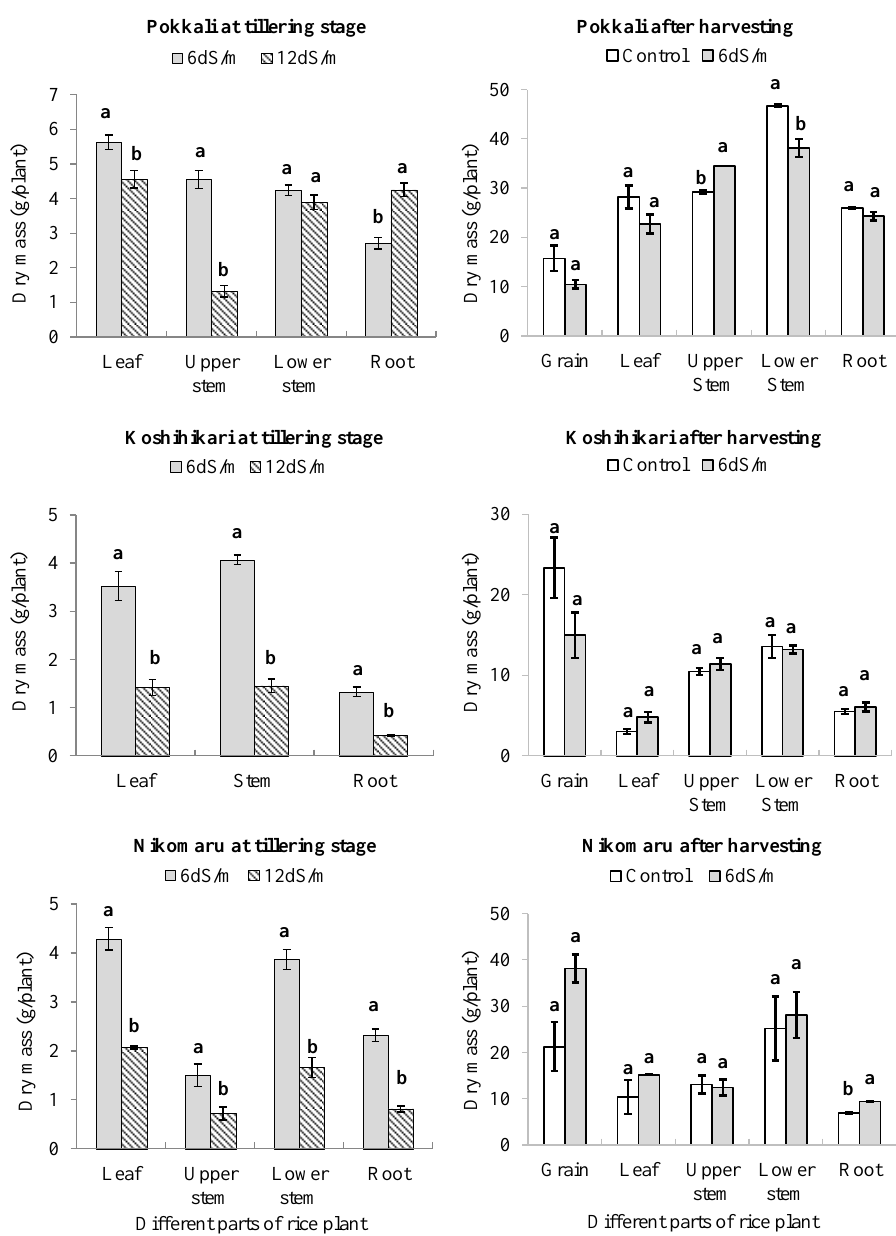
Figure 1. Average dry mass of different parts of the rice plant body in the tillering stage (under 6 and 12 dS/m saline irrigation) and in the reproductive stage (under control and 6 dS/m saline irrigation). Error bars represent standard errors ( n = 6). Different letters on bars indicate statistical difference at p ≤